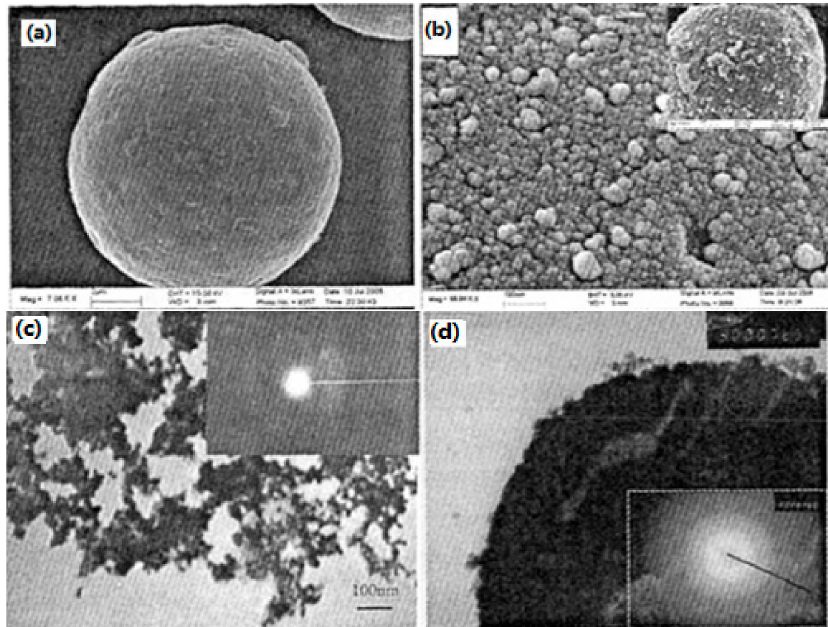
Figure 11. SEM and transmission electron microscopy (TEM) photographs of di ff erent samples. ( a ) Raw Al powder; ( b ) Al / B / Ni nano-sized composite particles. Reproduced from [36], with permission from Elsevier, 2016; ( c ) Ni / B nano-sized alloy; and ( d ) Al / B / Ni nano-sized composite particles. Reproduced from [50], with permission from Han Neng Cai Liao,